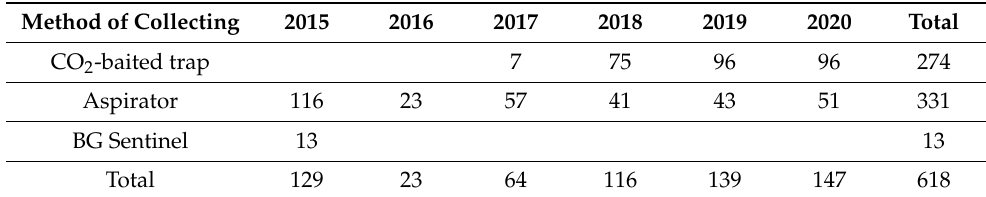
Table 1. Number of mosquito collecting using different methods at all sites. Method of